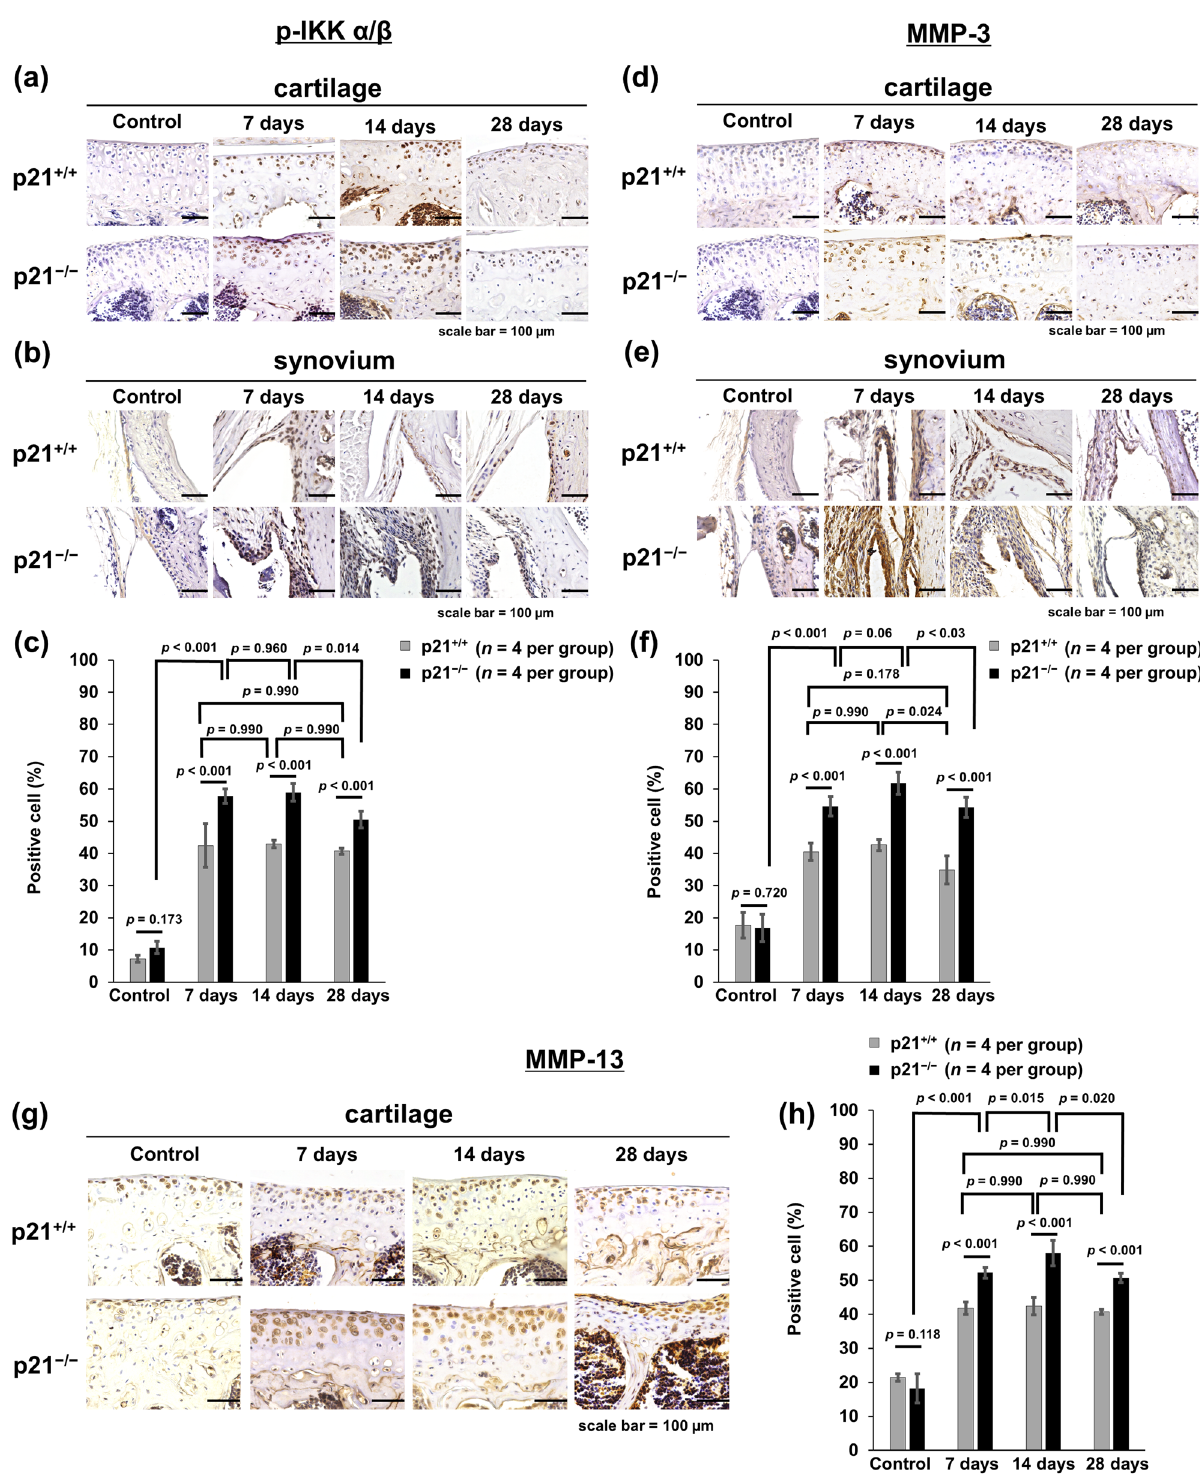
Figure 4. p21 levels influence the numbers of p-IKKα/β-, MMP-3- and MMP-13-positive cells in the CAIA mouse model. ( a,d,g ) Cartilage and ( b,e ) synovial tissue samples were collected from the knees of mice after antibody cocktail administration. ( a,b,d,e,g ) p21 +/+ mice and p21 −/− mice as control, on days 7, 14, and 28. ( c ) The percentage of p-IKKα/β-stained cells (number of positive cells/total number of cells) with 95% CI. ( f ) The percentage of MMP-3-stained cells with 95% CI. ( h ) The percentage of MMP-13-stained cells with 95% CI. The sections were counterstained with hematoxylin. ( c,f,h ), four mice were analyzed from each group. Two- way analysis of variance and Tukey’s post hoc test for multiple comparisons of paired samples were used. CI confidence interval, IKK IκB kinase complex, CAIA collagen antibody-induced arthritis, p21 cyclin-dependent kinase inhibitor